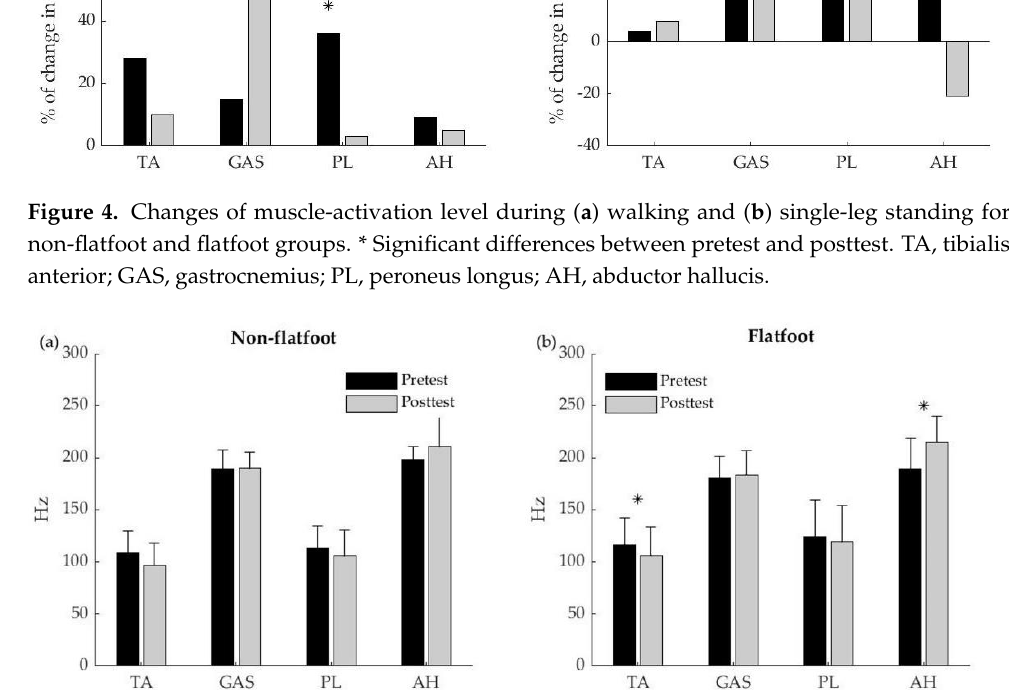
Figure 5. Median frequency for ( a ) non-flatfoot and ( b ) flatfoot groups. * Significant differences be- tween pretest and posttest. TA, tibialis anterior; GAS, gastrocnemius; PL, peroneus longus; AH, abductor hallucis.